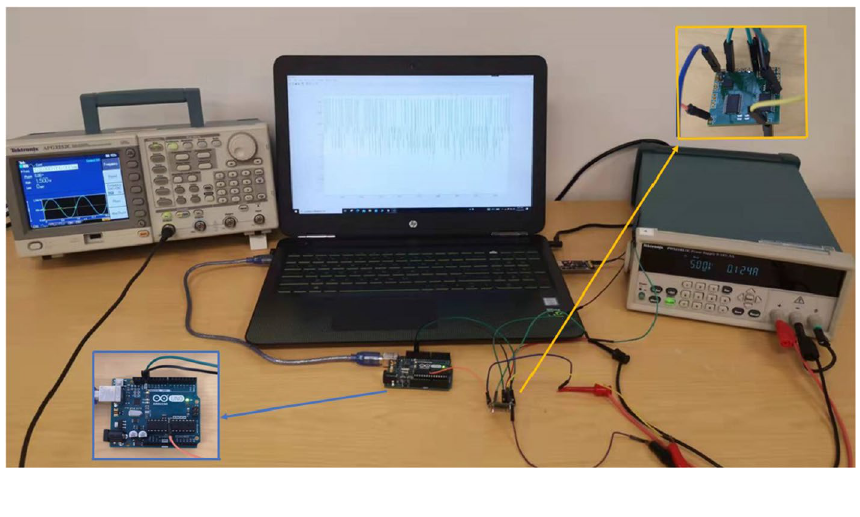
Fig. 6 a Instructions in the pipeline during clock cycles i − 1 , i , and i + 1 ; b